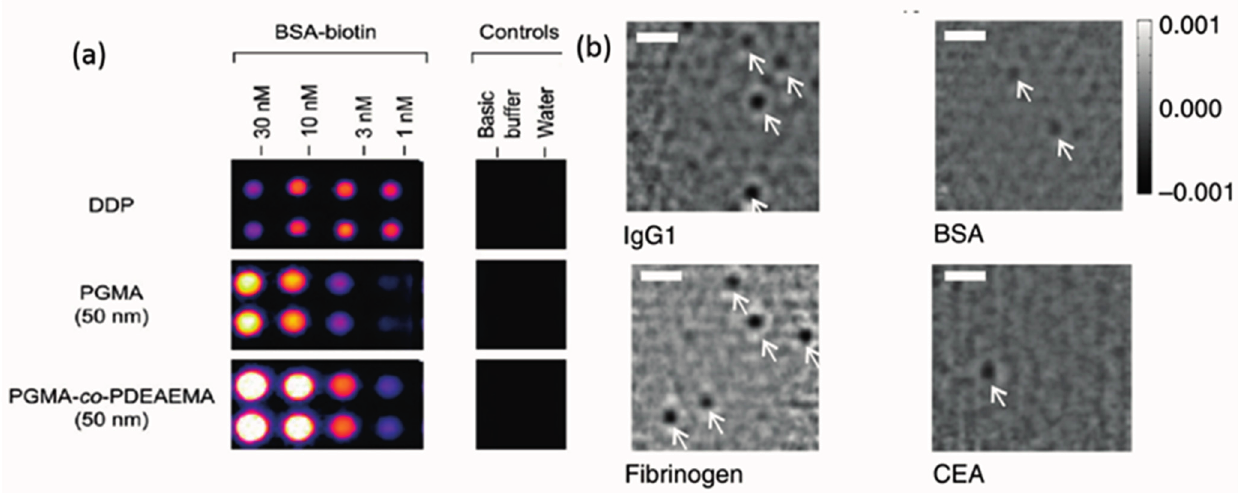
Figure 14. ( a ) Fluorescence detection on three brush types and loading intensities detected (DDP: dodecyl phosphate) (Reproduced with permission from Reference [183] Copyright 2010, American Chemical Society); and ( b ) iSCAT detection of single molecules on a polyethylene glycol brush, molecules indicated by white arrows (scale bar: 1 µm). (Reproduced with permission from Reference [181]. Copyright 2014, Nature